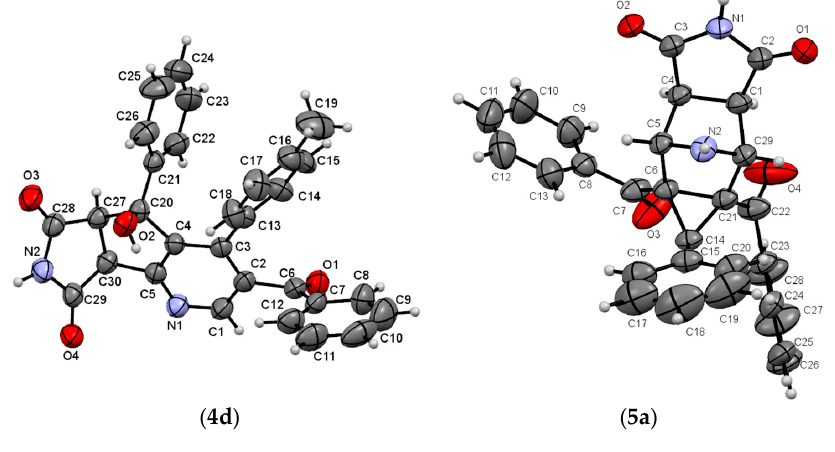
Figure 1. Cont. Figure 1. Cont.